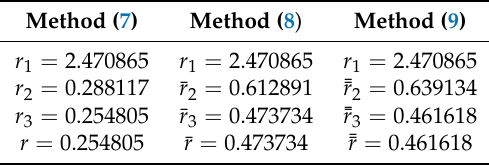
Table 3. Numerical results for Example